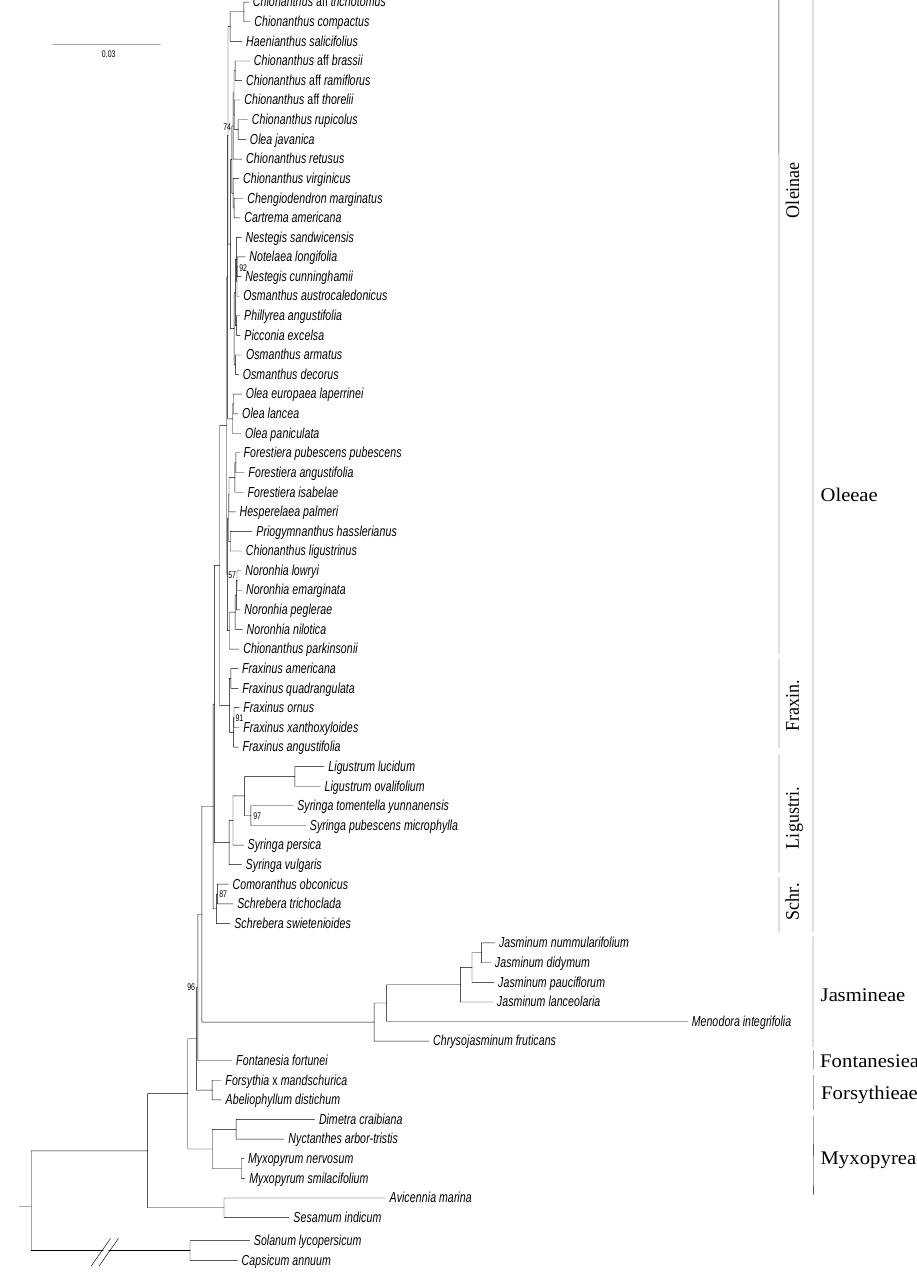
Figure 1. Maximum likelihood phylogenetic tree of Oleaceae based on concatenated coding sequences of 80 plastid genes. The tree was rooted on the split with Solanaceae. The scale is in substitution per site. Ultrafast bootstrap support values are indicated on nodes when inferior to